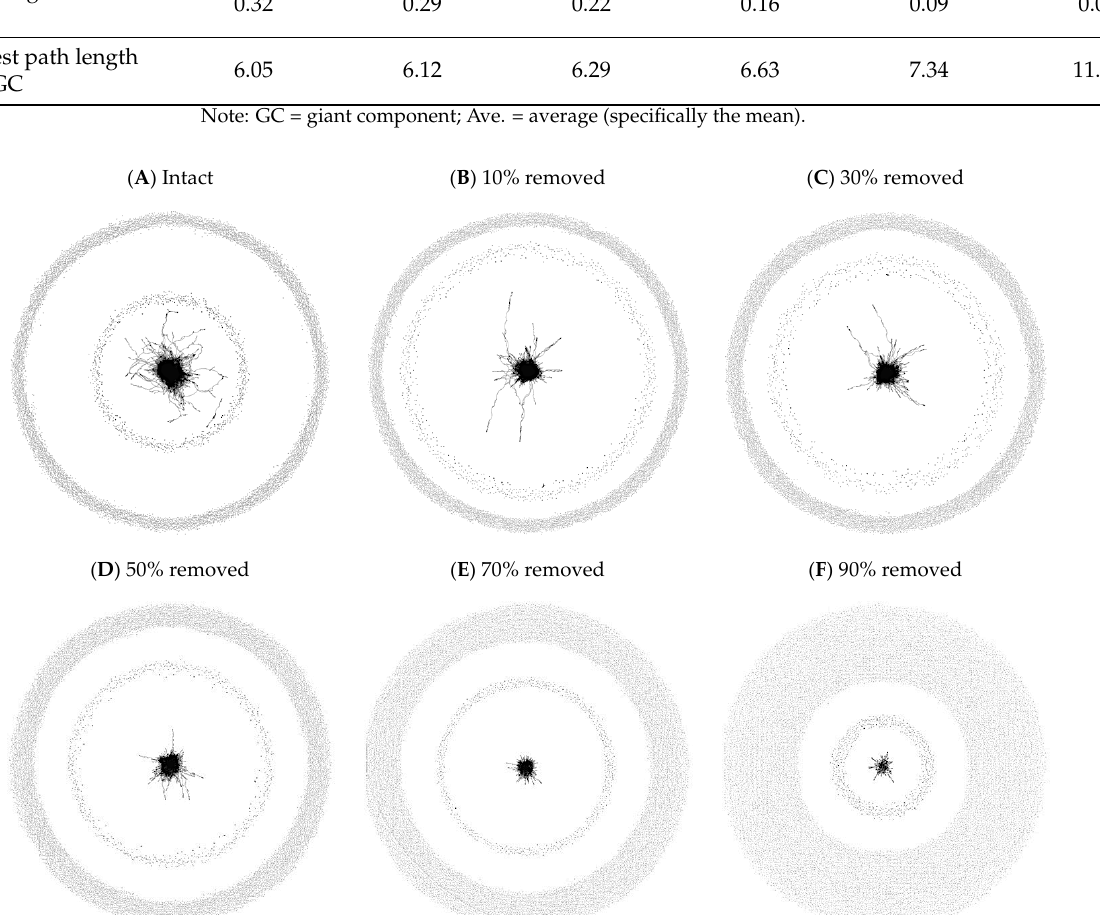
Table 1. Network measures of the intact and damaged networks. Intact